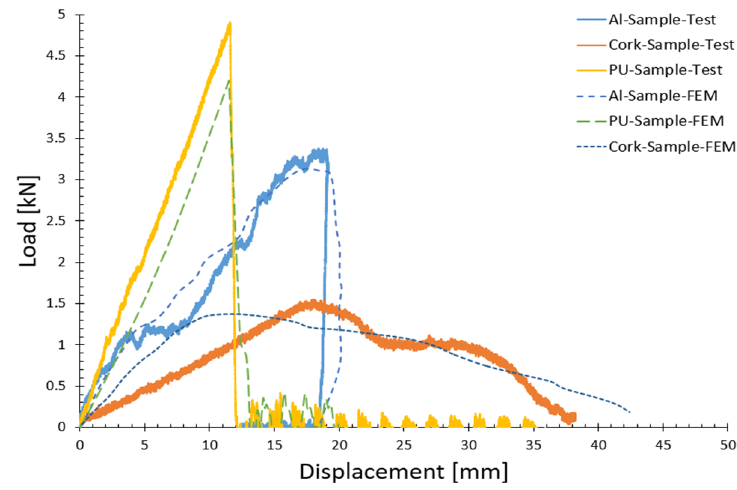
Figure 6. Experimental and FE load-displacement curves from the impact tests.